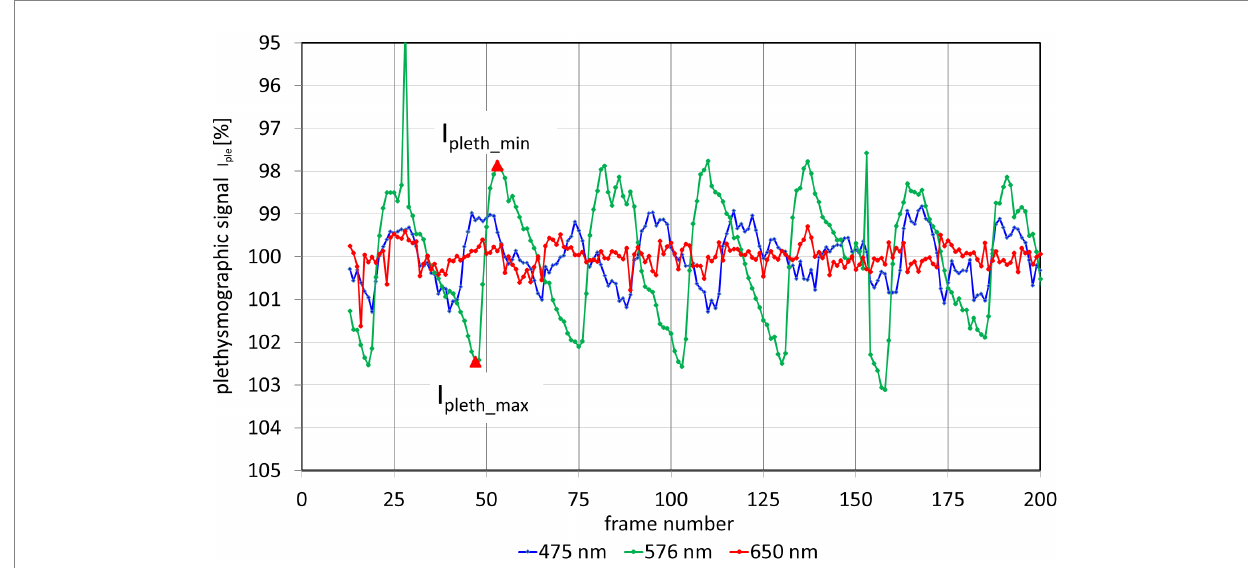
FIGURE 4 Plethysmographic signal I pleth for 3 different wavelength. The y-axis of the plethysmography signal is inverted so that increasing blood volume (decreasing light intensity) results in an increase of the signal (and vice versa). The outliers in the 576 nm signal (at frames 28 and 152) are due to fast eye movements and blinks. From these plethysmographic signals the pulsatile absorption amplitude PAA can be calculated for each wavelength. As an example, the red triangles show the values I pleth_min and I pleth_max for the second heartbeat of the 576 nm